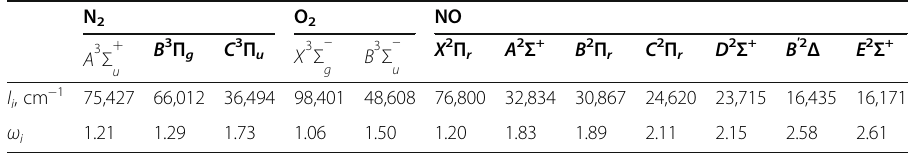
Table 3 The values of ω i for diatomic molecules N 2 O 2 NO þ B 3 Π A 3 Σ u